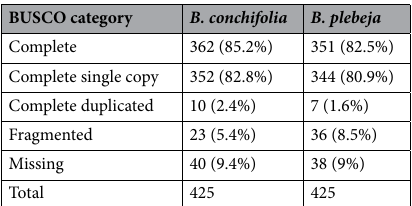
Table 2. BUSCO assessment of transcriptome completeness for B. conchifolia and B. plebeja .